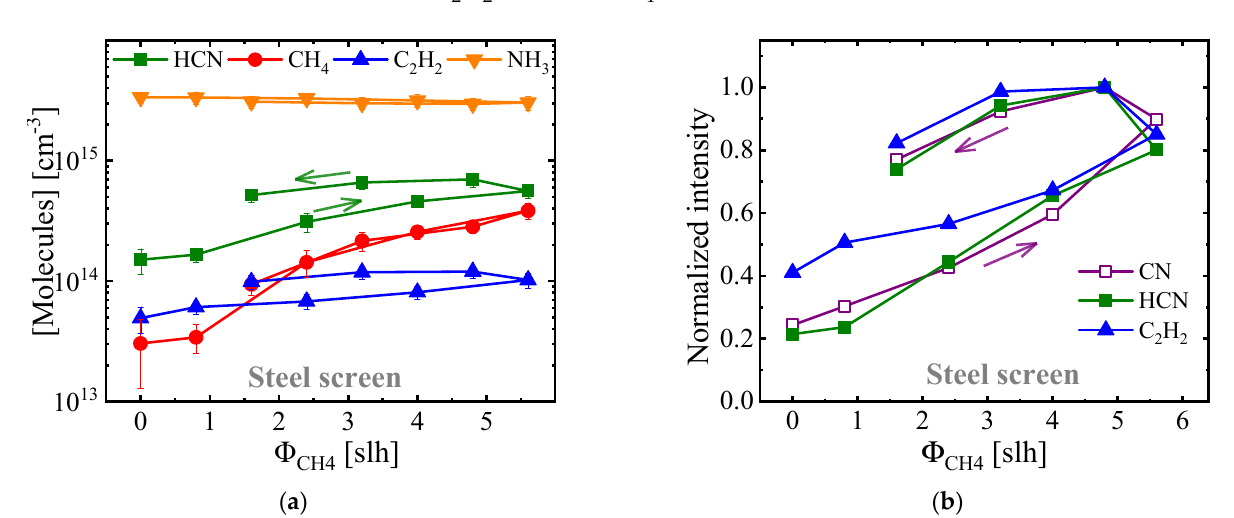
Figure 5. Concentrations of HCN, C 2 H 2 , CH 4 , and NH 3 measured as functions of the CH 4 flow rate from LAS ( a ) and